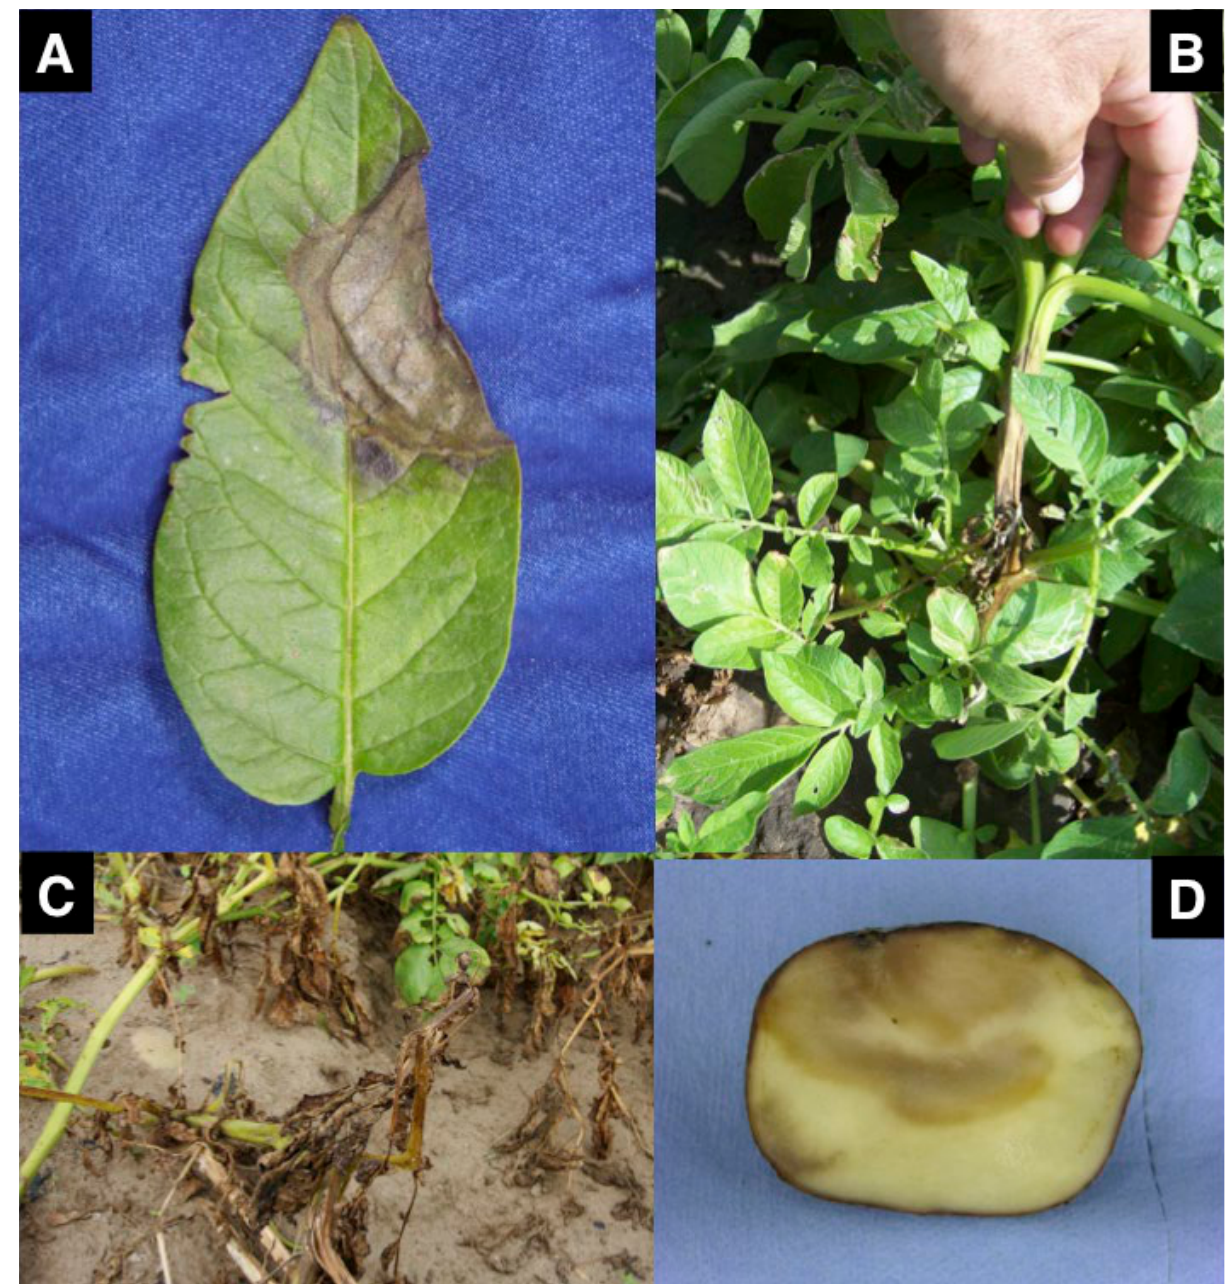
Figure 3. Symptoms associated with Phytophthora nicotianae infection on potato. (A) Leaflet field infection; (B) stem infec- tion; (C) foliar infection; (D) tuber